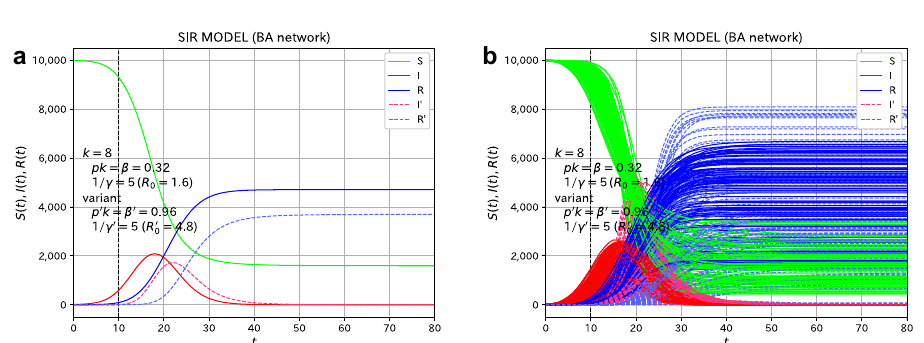
Figure 7. Effects of variants for the spread of the epidemic disease on the BA network. Suppose that 10 individuals are infected with the variant ( R ′ 0 = 4.8 ) by an external factor at t = 10 . ( a ) The plot of all 100 samples. ( b ) The average of the 100 samples. The red and blue dashed lines indicate the values of